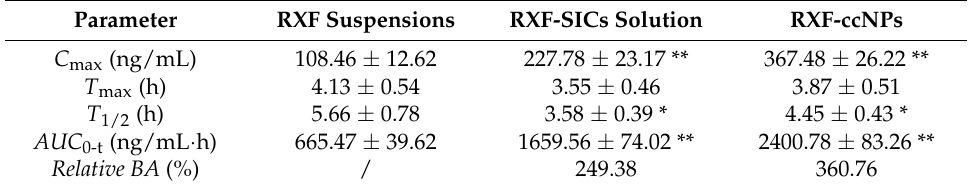
Table 1. Pharmacokinetic parameters of RXF in rats following oral administration of RXF suspensions, RXF-SICs solution and RXF-ccNPs at the dose of 50 mg/kg ( n = 6, mean ± SD).